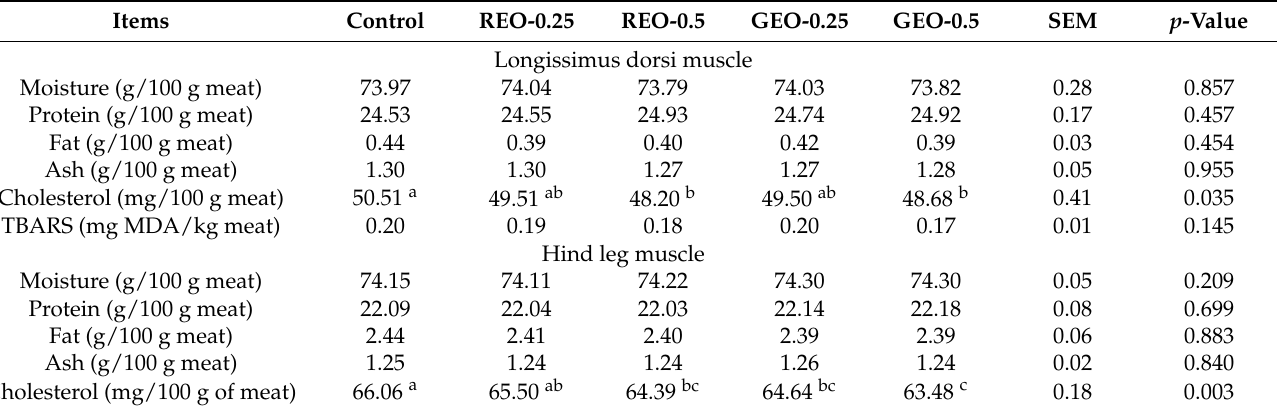
Table 5. Effect of the dietary supplementation of rosemary and ginger essential oils on meat composi- tion traits of the growing NZW rabbits at the end of the experiment ( n =